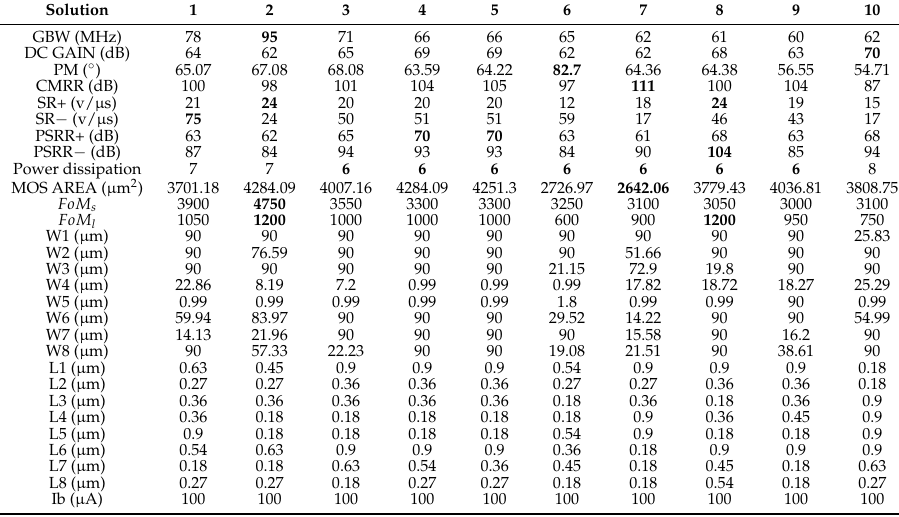
Table 5. Electrical characteristics and feasible W/L sizes of the RFC-OTA guaranteeing DCOP conditions of the MOS transistors applying MOL for the best 10 runs. The best values are highlighted in bold